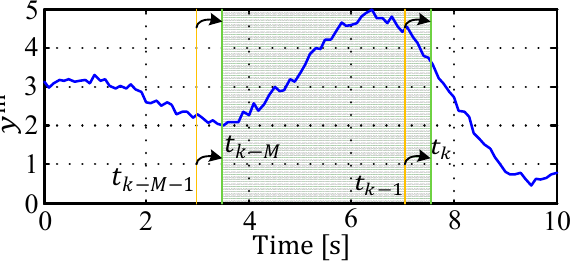
Figure 8. Schematic representation of a moving measurement window.